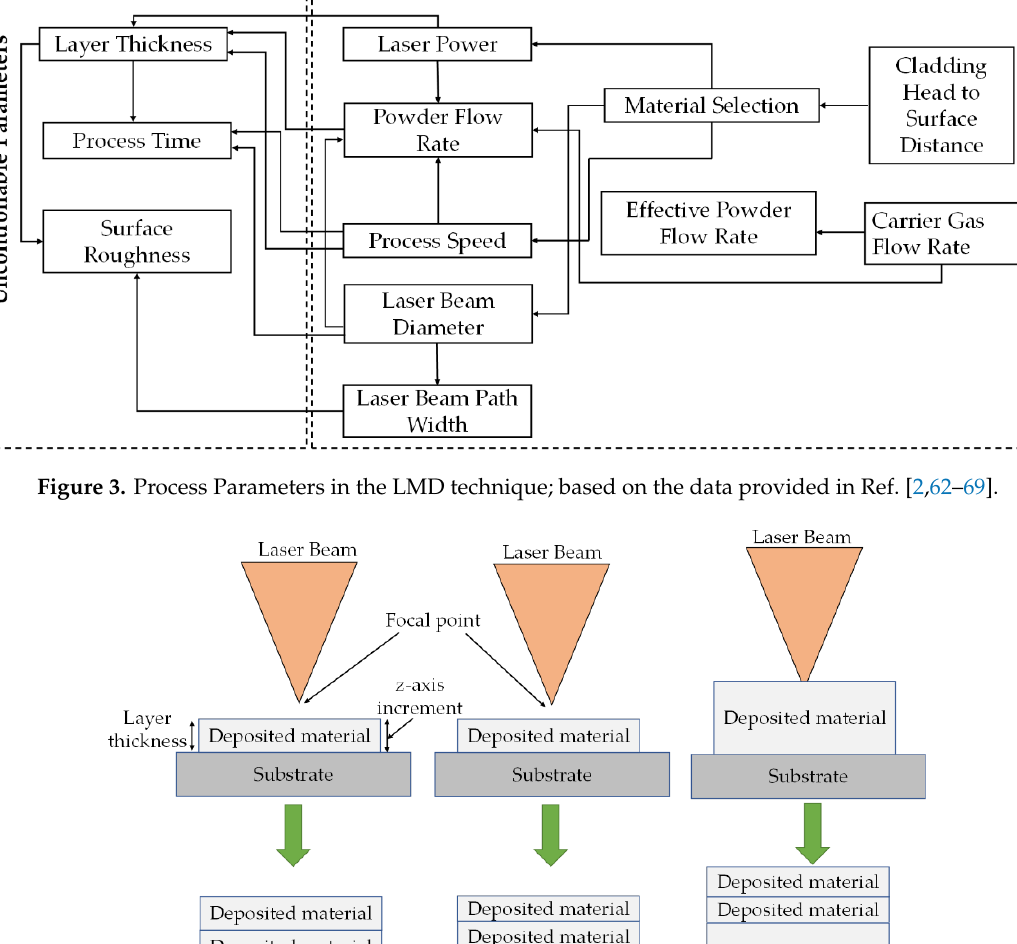
Figure 3. Process Parameters in the LMD technique; based on the data provided in Ref. [2,62 – 69].